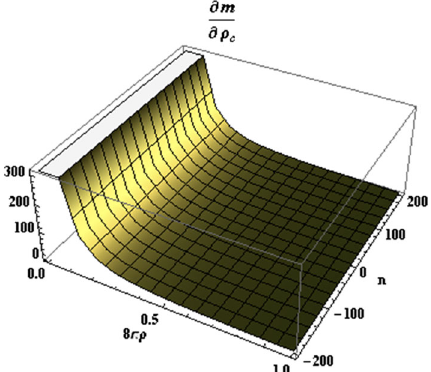
Fig. 5 (Left) In this figure, along x -axis, y -axis and z -axis we have respectively plotted the radius of the star in km unit, the dimension- less quantity n which lies in the range − 200 ≤ n ≤ 200 and ρ − p r in MeVfm − 3 unit. (Middle) Along x -axis, y -axis and z -axis we have respectively plotted the radius of the star in km unit, the dimension- less quantity n which lies in the range − 200 ≤ n ≤ 200 and ρ − p t